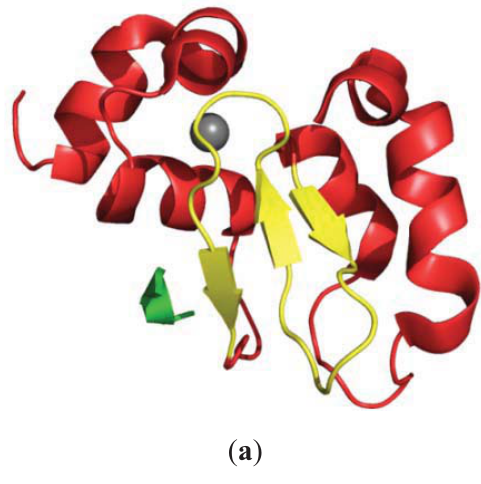
Figure 1. Structure of the Inhibitors of apoptosis. ( a ) Structure of the cellular IAP1 (cIAP1)-baculoviral IAP repeat (BIR)3 bound to the caspase-9 N -terminal peptide [30]. BIR3 is organized in four (cid:3)-helices (red) and 3 (cid:4)-strand sheets (yellow) maintained by zinc ion (grey). The interaction involved the surface hydrophobic groove of cIAP1 and the N -terminal peptide (ATPFQ) of the caspase 9 sub-unit (Constructed using the PyMOL Molecular Graphics System). ( b ) Representation of IAPs involved in the regulation of apoptosis. The type I baculoviral IAP repeats (BIR, blue) of cIAPs and X-linked IAP (XIAP) can bind to cell signalling intermediates TNFR associated factor 2 (TRAF2) and Transforming Growth Factor beta-activated kinase 1-binding protein 1 (TAB1), respectively. The type II BIRs (brown) contain a surface hydrophobic groove allowing the interaction with IBM found in caspase sub-units and IAP antagonists. The ubiquitin Associated (UBA) domain binds ubiquitin chains. The caspase recruitment domain (CARD) is a module of regulation of the RING E3-ubiquitin ligase activity. The RING domain confers to IAPs an E3-ubiquitin ligase activity. NACHT (domain present in NAIP, CIITA, HETE and TP1). LRR: Leucine Rich